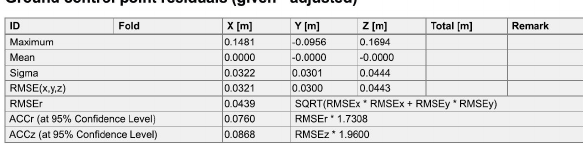
Figure 20 . Improved aerotriangulation in high forested areas by using VCP from LiDAR